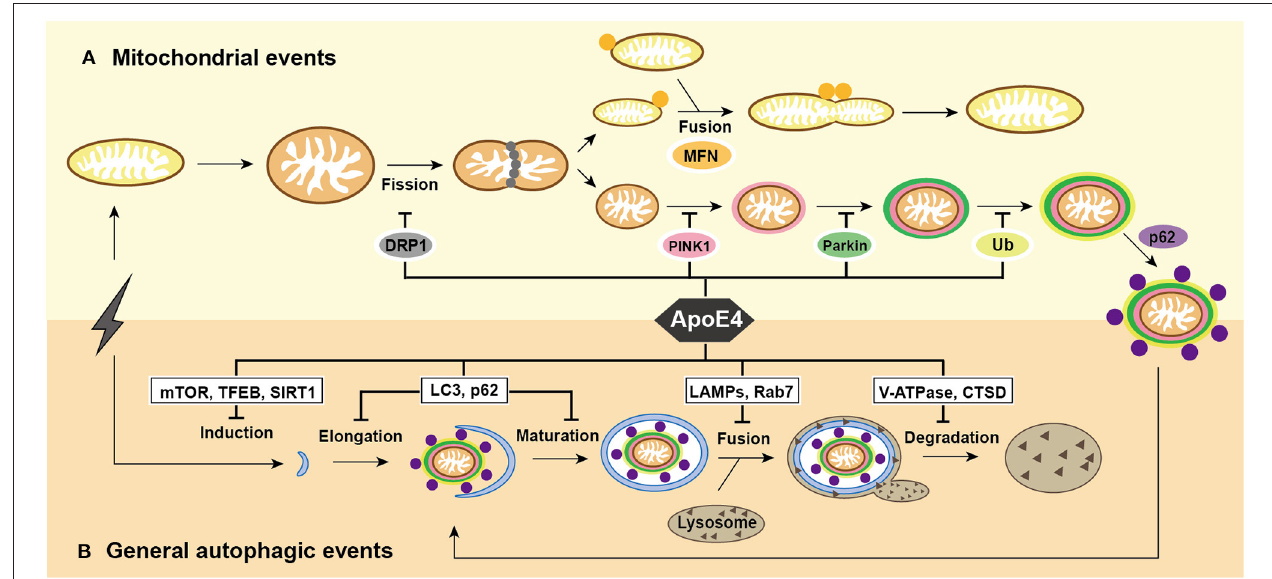
FIGURE 1 | Summary of mitochondrial events and general autophagic events under ApoE4 intervention. (A) After excessive cellular stress, mitochondria begin to swell and fragment into healthy mitochondria for fusion, and pre-degraded mitochondria for mitophagy. damaged mitochondria induce PINK1/Parkin pathways and then participate in general autophagic flux. ApoE4 is directly or indirectly involved in mitochondrial events, including DRP1 pathways during fission; the MFNs pathways during fusion; and the PINK1/Parkin pathways during mitophagic induction. (B) After excessive cellular stress, the omegasome is initiated to form an elongated into a phagophore, which encloses the damaged mitochondria and becomes a mature autophagosome. Lysosomes recruit to autophagosome and fuse with it to form autolysosome, the ultimate area of mitochondrial degradation. ApoE4 intervenes autophagic initiation by the mTOR, TFEB, and SIRT1 pathways; compromises elongation by LC3, p62, and Rab5 pathways; blocks autophagosome-lysosome fusion by the Rab7, LAMP2, and LAMP1 pathways; damages lysosomal degradation by CTSD and V-ATPase